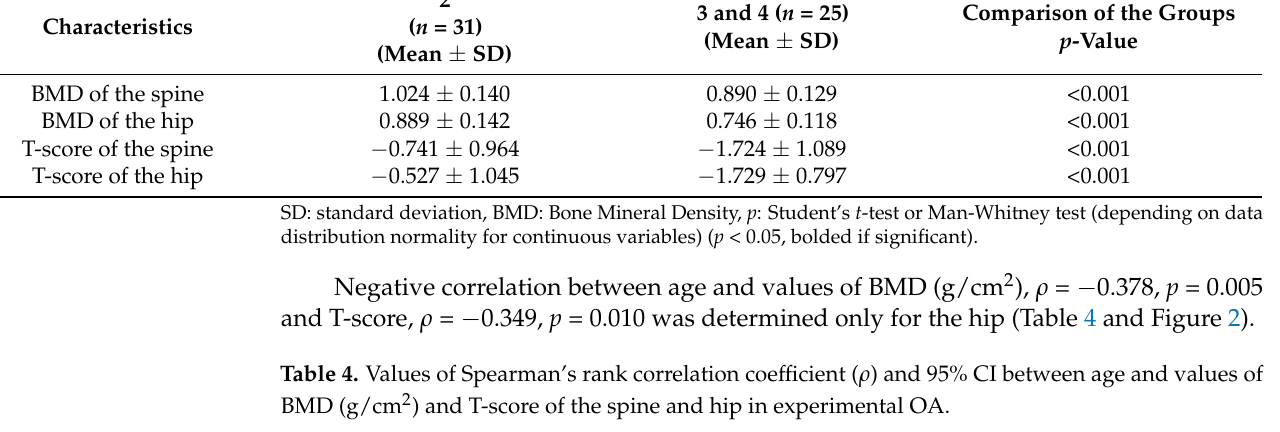
Table 3. BMD (g/cm 2 ) and T-score values of the spine and hip in relation to the radiological median grades of OA severity (K&L) in the experimental group. RTG Classification (K&L)